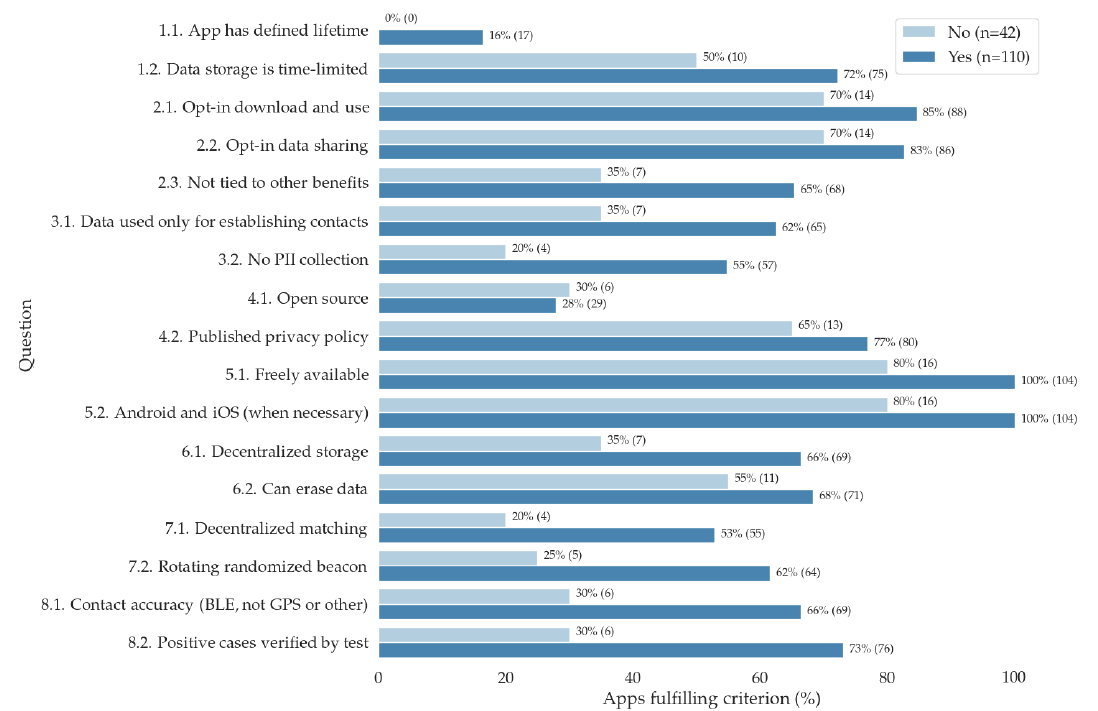
Figure 6. Proportions of government-backed ( n =42) vs. non-government-backed ( n =110) apps responding affirmatively to each question. For all criteria except for whether the app was open source, the government-backed apps scored higher on average.